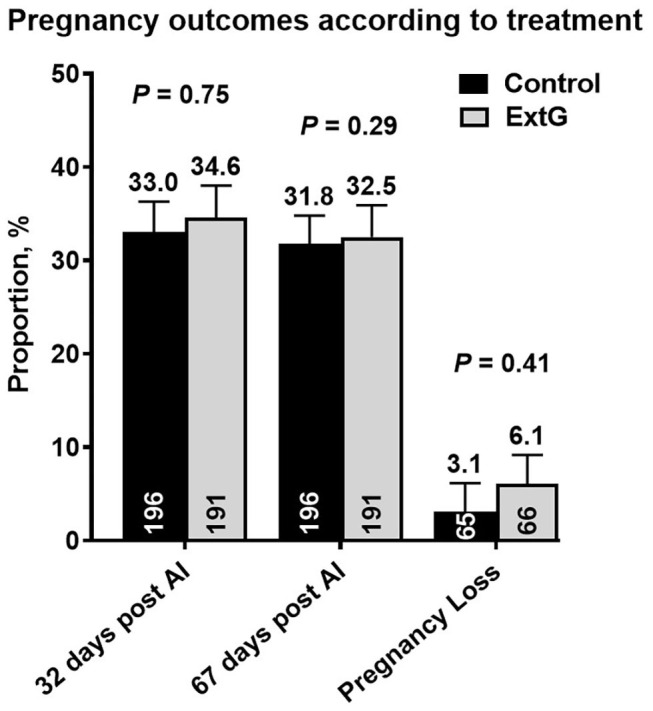
Bar graph illustrating the proportion of pregnant cows at days 32 and 67 post-AI and proportion of pregnancy loss according to the effects of treatment (Control vs. ExtG). The mean proportion for each bar is listed above each error bar, whereas the number of cows per treatment is at the bottom of each bar. Error bars represent the standard error of the mean.